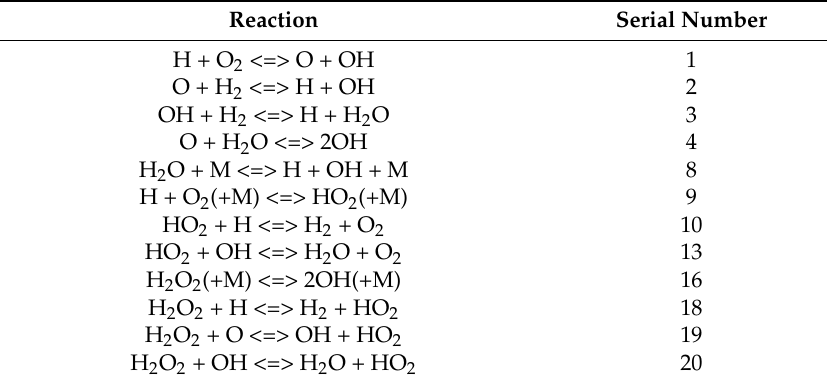
Table 2. Elementary reactions sequence in recombination